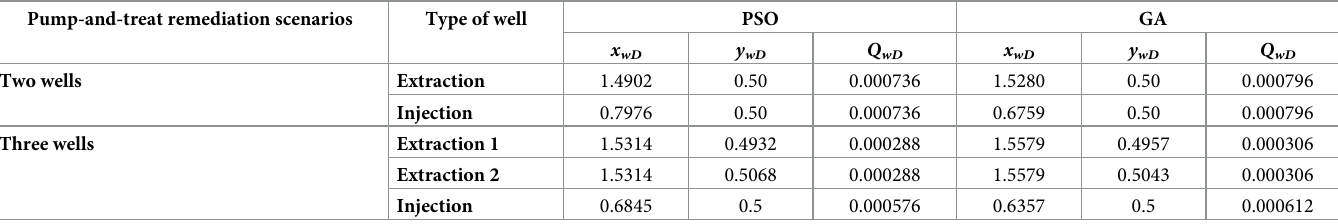
Table 3. Extraction/injection rates and well positions in two remediation scenarios. Pump-and-treat remediation